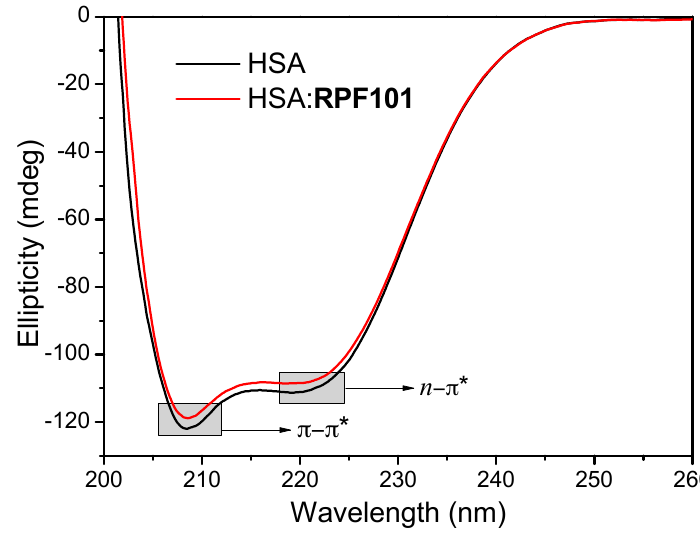
Figure 6. Circular dichroism spectra for HSA without and in the presence of RPF101 in PBS buffer solution (pH = 7.4) at 310 K. [HSA] = 1.00 × 10 − 6 M and [ RPF101 ] = 1.32 × 10 − 5 M.